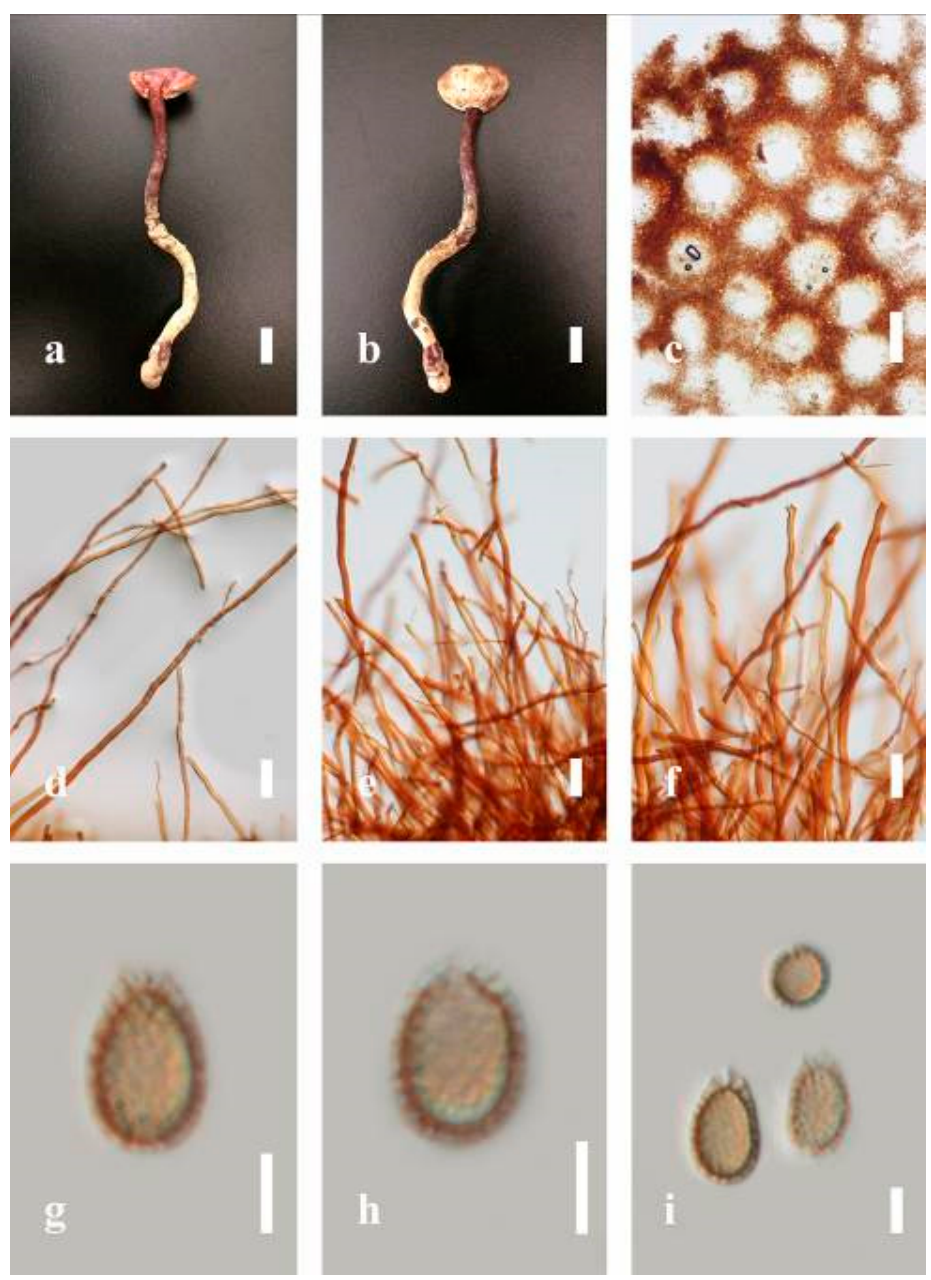
Figure 26. Morphology of Ganoderma lucidum (MFLU 19 ‐ 2162): ( a , b ) mature basidiomes; ( c ) pore characteristics; ( d ) generative hyphae of context in KOH; ( e , f ) generative. skeletal and binding hyphae of context in KOH; ( g – i ) basidiospores. Scale bars: ( g , i ) = 2 cm, ( c ) = 200 μ m, ( d – f ) = 20 μ m, ( g – i ) = 5 μ m. Ganoderma multipileum Ding Hou. (1950) (Figure 27) Facesoffungi number: FoF 06256 Description: Basidiomes annual, stipitate. Pileus up to 6–11 cm in length, 4–9 cm in width, and 1–3 cm thick at base. Pileus sub ‐ reniform to reniform, subflabellate to flabel ‐ late, concentrically sulcate zone, fleshed at center slightly to margin, radial or branched from center extend to the margin when seen from above, tough when break, often thick at center slightly soft at margin, and leathery when age when break. Pileus surface weakly laccate to strong laccate at center when mature to age, and faded or week laccate at active mycelial (margin), smooth, irregularly ruptured crust overlying the context, some woody